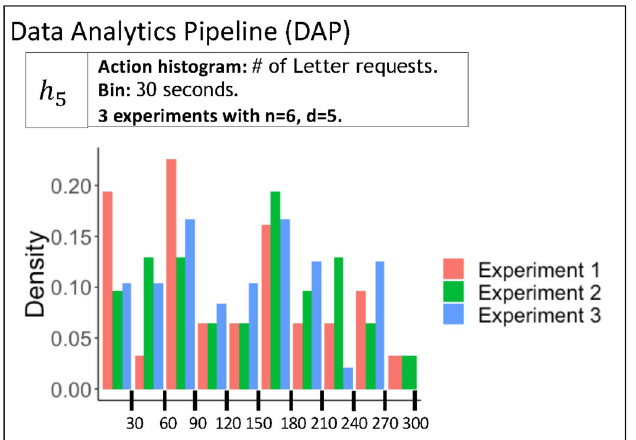
Fig 15. The Data Analytics Pipeline (DAP) was executed to analyze phase 2 of three experiments with n = 6 and d = 5. The histogram for the number of actions “letter request” for three experiments is generated by function h 5 . The x-axis is time in the group anagram game, binned in 30 seconds intervals.